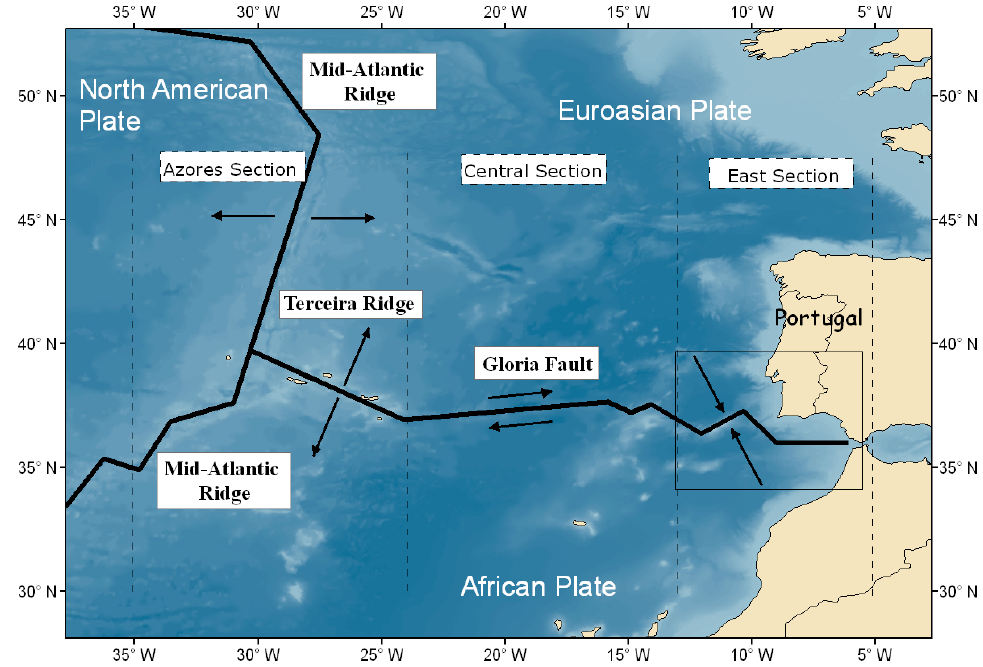
Figure 2. Plate tectonics of the Atlantic North East, and the location of the east section. The rectangle on the east section will be explained in more detail [4].